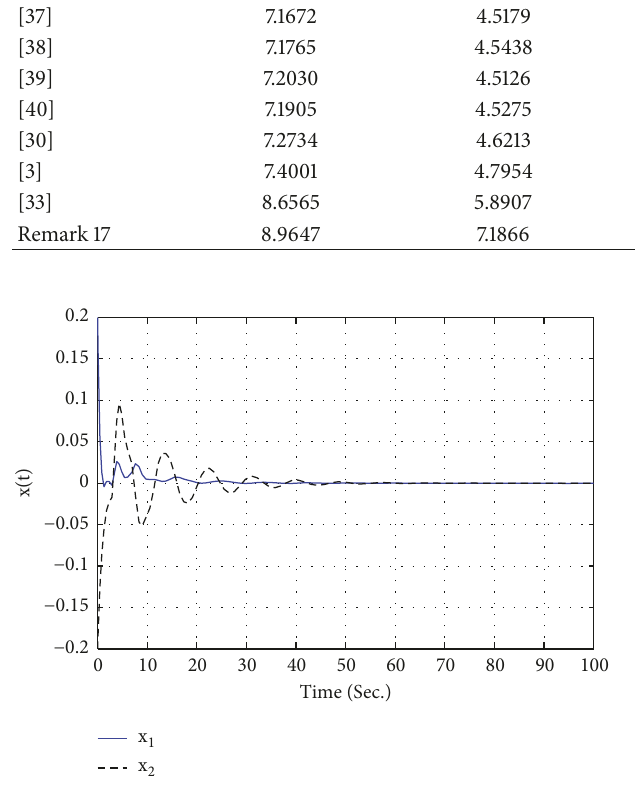
Figure 3: The state responses for Example